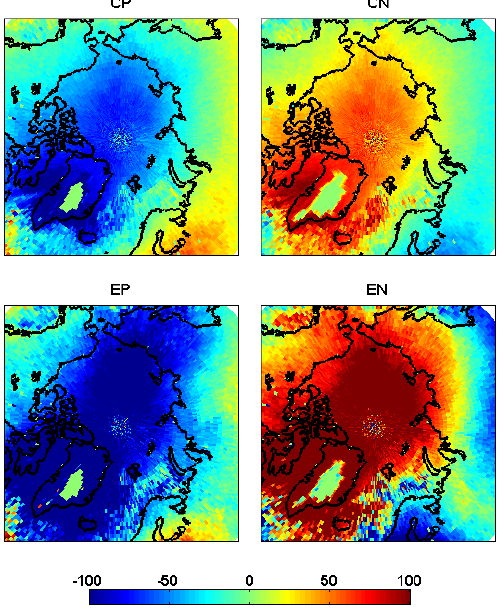
Fig. 2: The AIRS-derived geopotential height anomalies (in meters) at 200 hPa showing Fig. 2. The AIRS-derived geopotential height anomalies (in me- typical signatures of the strong and weak strengths of polar vortex during the chosen four ters) at 200hPa showing typical signatures of the strong and weak phases of the AO. strengths of polar vortex during the chosen four phases of the AO.